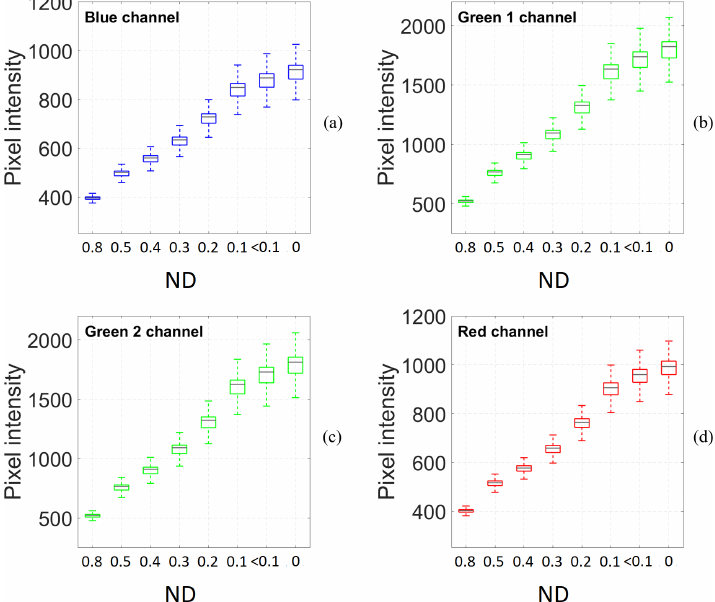
Figure 6. Distributions of the calibration image intensities for the blue ( a ), green 1 ( b ), green 2 ( c ), and red ( d ) camera pixels [1450, 200], [1620, 800], [945, 1200], and [400, 100] (counted after image debayerization) for a microscope objective Nikon Plan: 40 × /0.65, ∞ /0.17, WD 0.56 (LED current: 4500 mA, ILCX: − 106 µ m, ILCY: − 201 µ